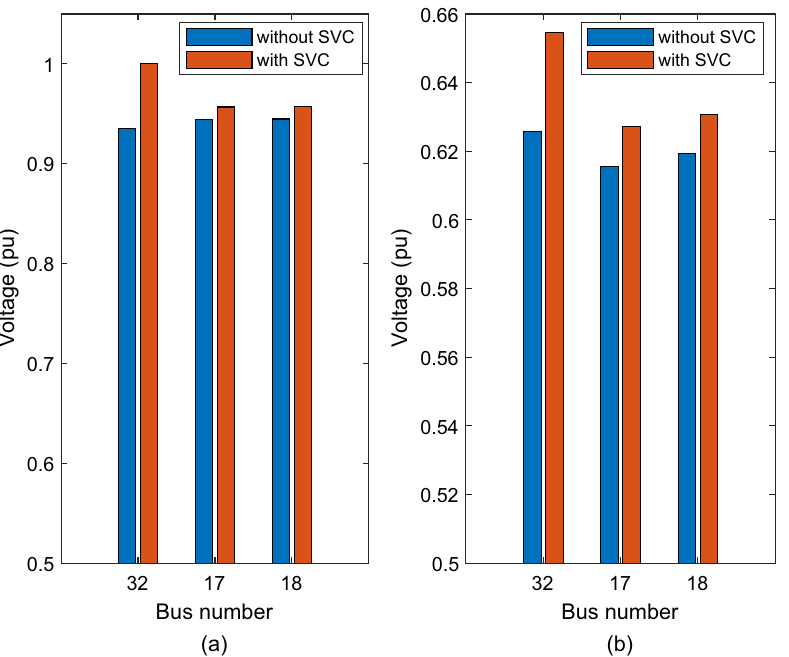
Figure 9. Voltage improvement after adding SVC at bus 32 (a) nominal load (b) heavy load.